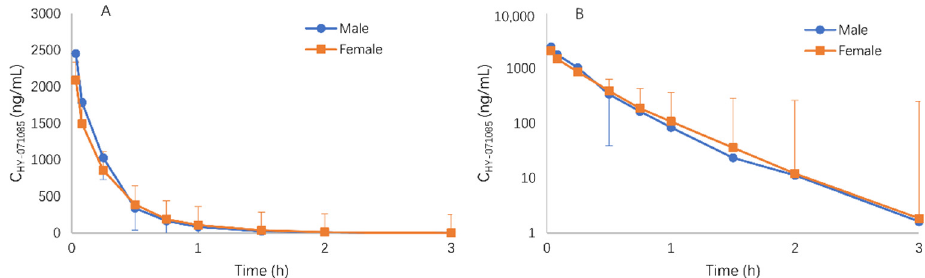
Figure 4. Mean plasma concentration–time curve of HY-071085 after the single-dose intravenous administration of 3.25 mg/kg HY-071085 in rats. ( A ) Constant coordinates; ( B ) semilogarithmic coordinates. 2.2. Pharmacokinetics after Repeated Doses of HY-071085 in Rats Male and female rats were given HY-071085 (6.5 mg/kg) by gastric gavage twice a day for 28 days. On days 14 and 18, blood samples were collected from the fundus venous plexus at various time points before and within 8 h after administration in order to analyze the concentration of HY-071085 in the plasma (Figure 5). The PK parameters are listed in Table 1. The results showed that the plasma drug exposure level of female rats had a downward trend compared with that of a single dose after 14 days of continuous administrations of 6.5 mg/kg per day; however, there was no significant change in the male rats. After 28 days of continuous administration, the plasma exposure levels of the male and female rats decreased by 49% and 85%, respectively, compared with that after a single administration (Figure 6). The results suggested that multidose administration may induce metabolic enzymes, leading to a significant decrease in the exposure